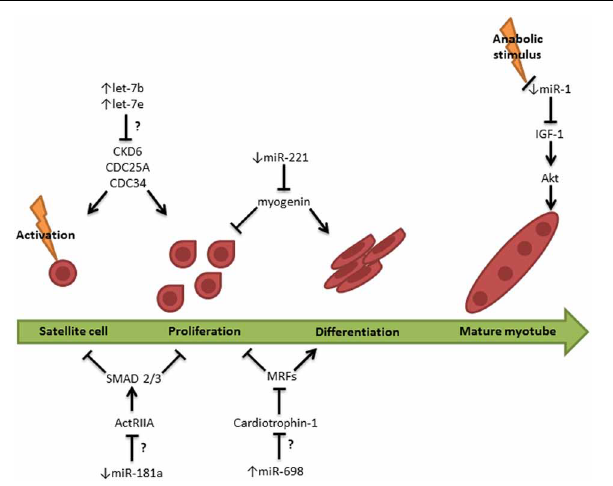
FIGURE 2 | The potential role of miRNAs in the attenuated myogenic process in the elderly. Let-7b and let-7e may contribute to the inhibition of satellite cell activation and proliferation via downregulating cell cycle regulators CKD6, CDC25A, and CDC34. In addition miR-181a may inhibit ActRIIA (activin type IIa receptor) and as a consequence permit activation of the proliferation inhibitors SMAD2/3. The combination of miR-221 and miR-698 further inhibits proliferation by down regulating various MRFs and driving terminal differentiation of the myocytes. Anabolic stimulus is known to reduce miR-1. Failure to downregulate miR-1 in elderly skeletal muscle following anabolic stimulation may contribute to anabolic resistance in mature myotubes via inhibition of IGF-1/Akt signaling., ↑ = stimulatory pathway; or, T = inhibitory pathway; ↑ , upregulated miRNA; ↓ , downregulated miRNA; ?, cause-and-effect relationship not